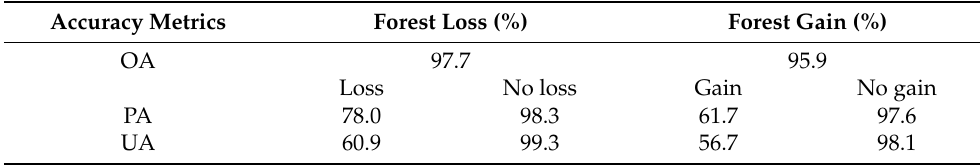
Figure 13. Distribution of points collected for validating the forest dataset in the Eastern Himalayas. Table 1. Accuracy of forest change detection.